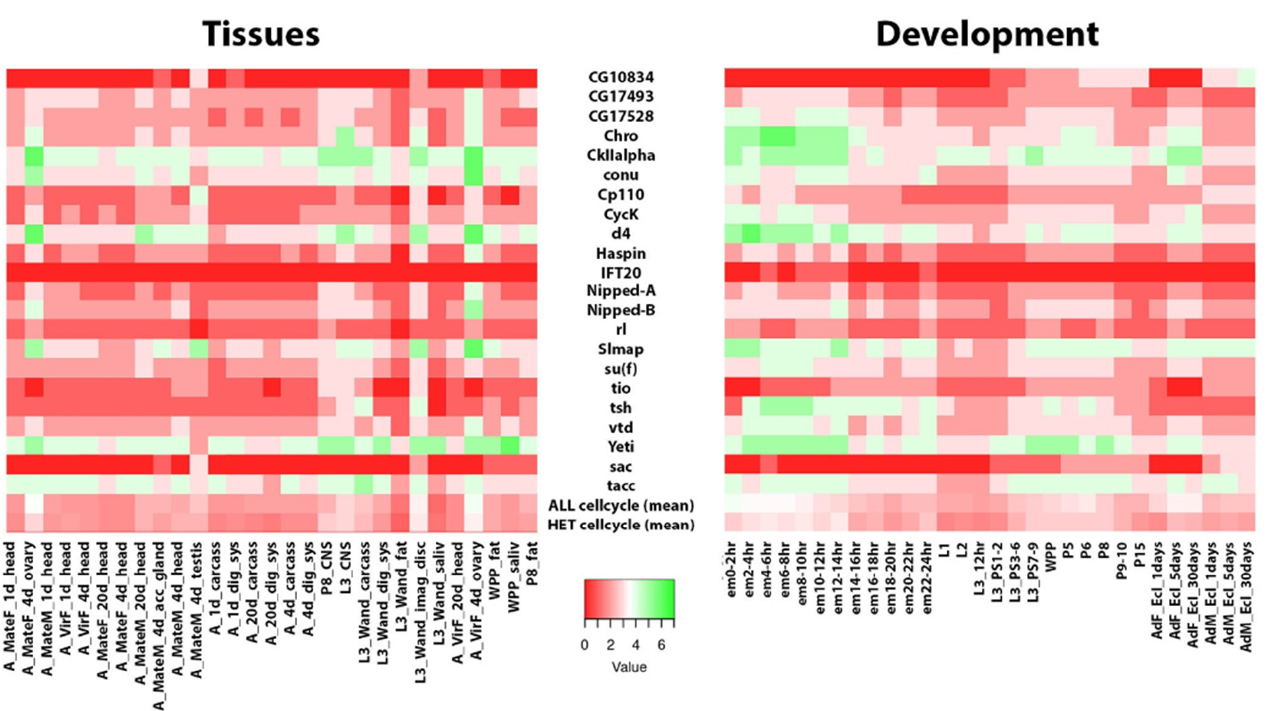
Figure 1. Heatmaps showing expression profiles of the examined single-copy coding genes. De- velopmental stages (left panel) and tissues expression (right panel). Shades of color from red to green indicate the expression bin classification from 1 (no/extremely low expression) to 7 (very high expression). Developmental stages and tissues expression data were obtained from FlyBase. Tissues (heads, ovaries, testis, carcasses, digestive system, CNS, fat, imaginal discs, and salivary glands) were obtained from different developmental stages, different timing, or different physio- logical conditions, as indicated (em: embryos; A: adults; L1–L3: larvae 1st–3rd instar; WPP: pupae early stage; P1–P15: late pupae; F/M: females/males; Mate/Vir: Mated/Virgin). “ALL cell cycle:” mean expression of 745 genes whose products are involved in cell division and for which expression data are available from ModEncode and obtained from FlyBase (textual search query “cell division”). “HET cell cycle”: mean expression of 22 heterochromatic genes discussed in this